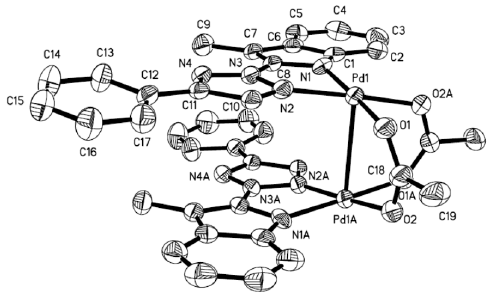
Figure 7. The emission spectra of compounds 3 ( f – r ).